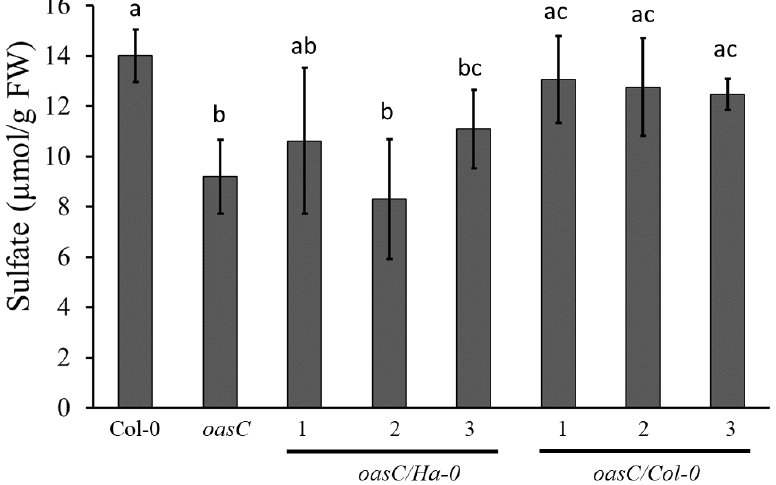
Figure 7. Transgenic complementation. Homozygous oasC mutants complemented either with Ha-0 or Col-0 allele of OASC were grown in soil in the greenhouse for four weeks. Sulfate levels in leaves were measured. Three lines were used for each construct. Data are presented as means ± S.D. from four biological replicates. Different letters denote significantly different values at p < 0.05 (Student’s t -test).